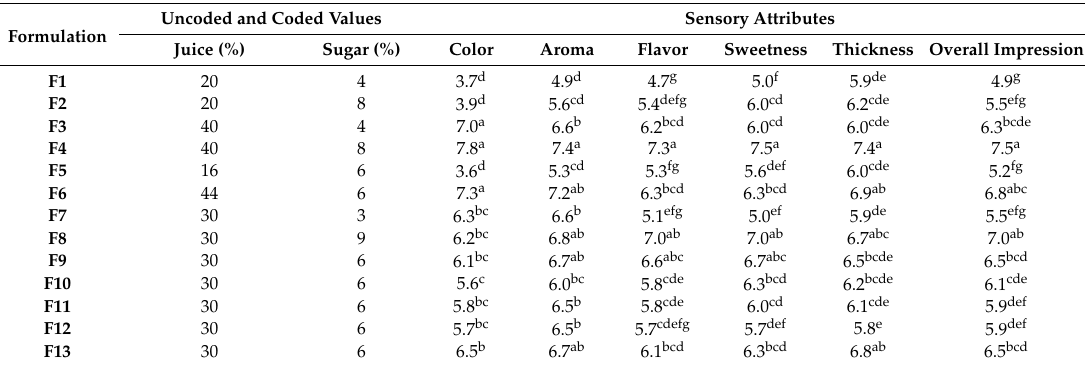
Table 2. Average results of sensory evaluation ( n = 130 consumers).